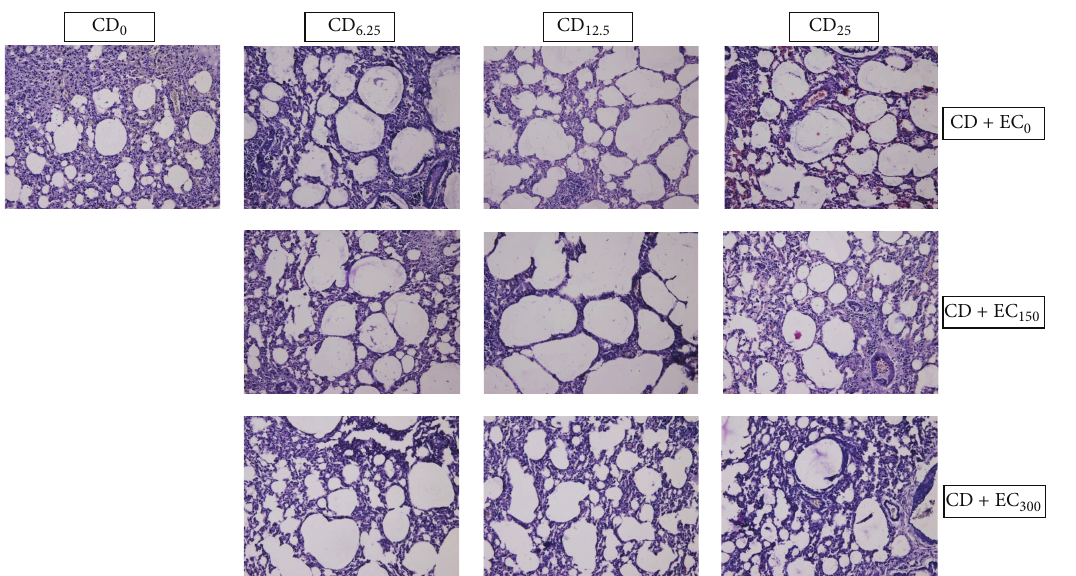
Figure 2: The morphology of lung in rats exposed to chronic coal dust and the effects of E. Cottonii supplementation (Hematoxyline Eosin staining, Magnification × 20). CD 6.25 induced lung parenchym edematous. This edematous process decreased in CD 12.5 and became necrosis in CD 25 . Chronic coal dust exposure increased the diameter of alveolus lumen. Besides, massive inflammatory cells were found in all coal dust exposure groups. CD 25 induces vasodilation and hemorrhagic. The oral administration of EC 150 and EC 300 is able to decreased the diameter of alveolus lumen similar to control, but inflammatory cells were still exist. In addition, this supplementation also is able to minimizes the hemorrhagic process.